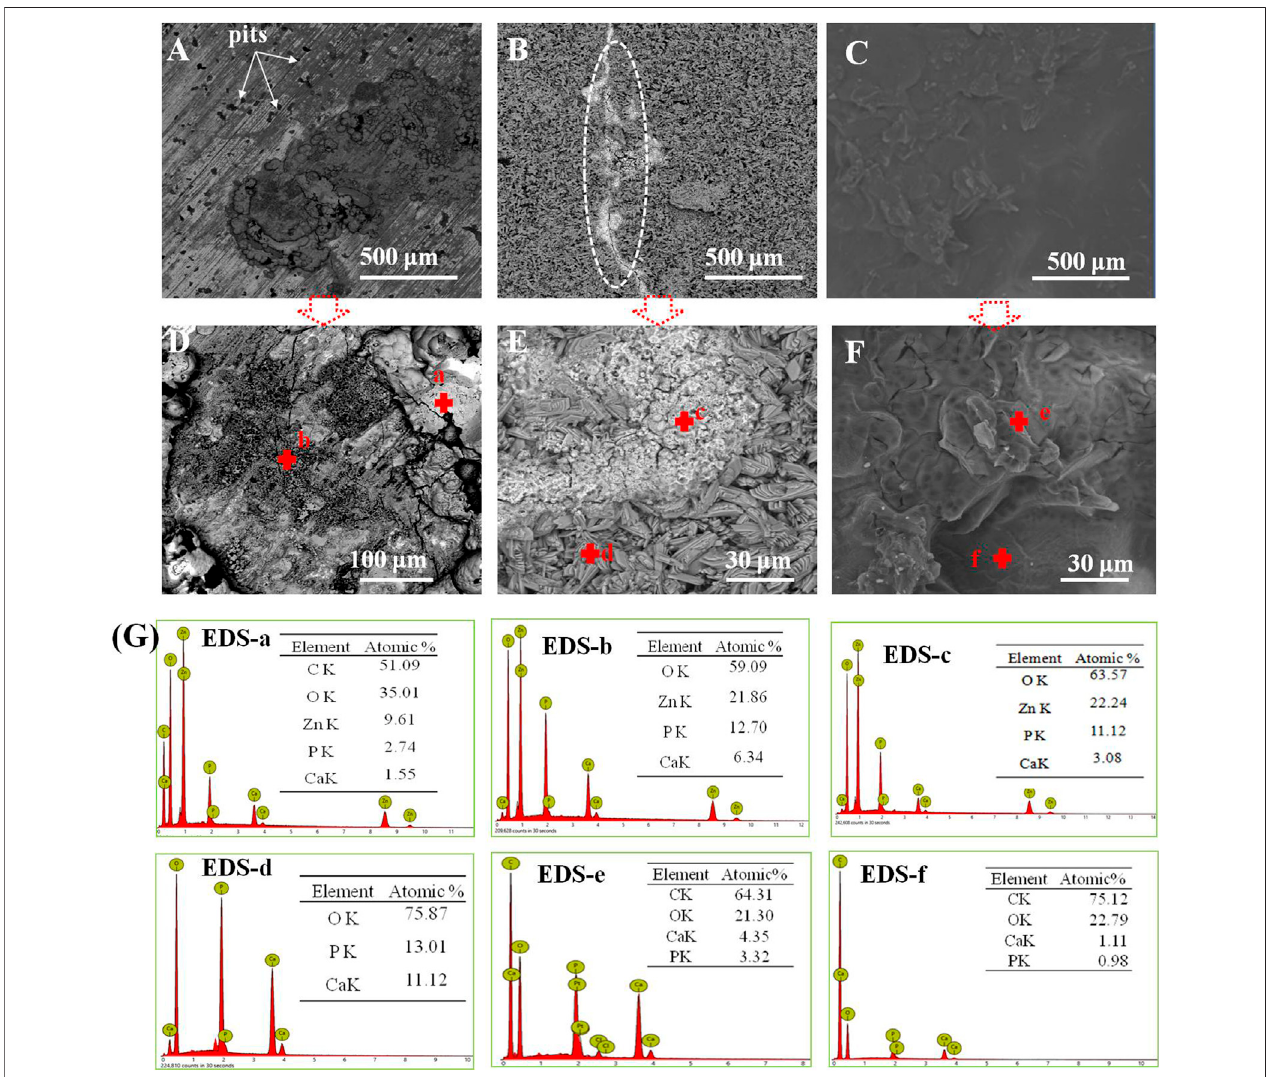
FIGURE6|(A – G) Themicrostructuresofthestudiedsamplesimmersed inSBFfor21 days andthecorrespondingEDSpatterns inpanel (G) : (A,D) purezinc; (B, E) Ca-P coating; (C, F) PLA/Li-OCP coating.